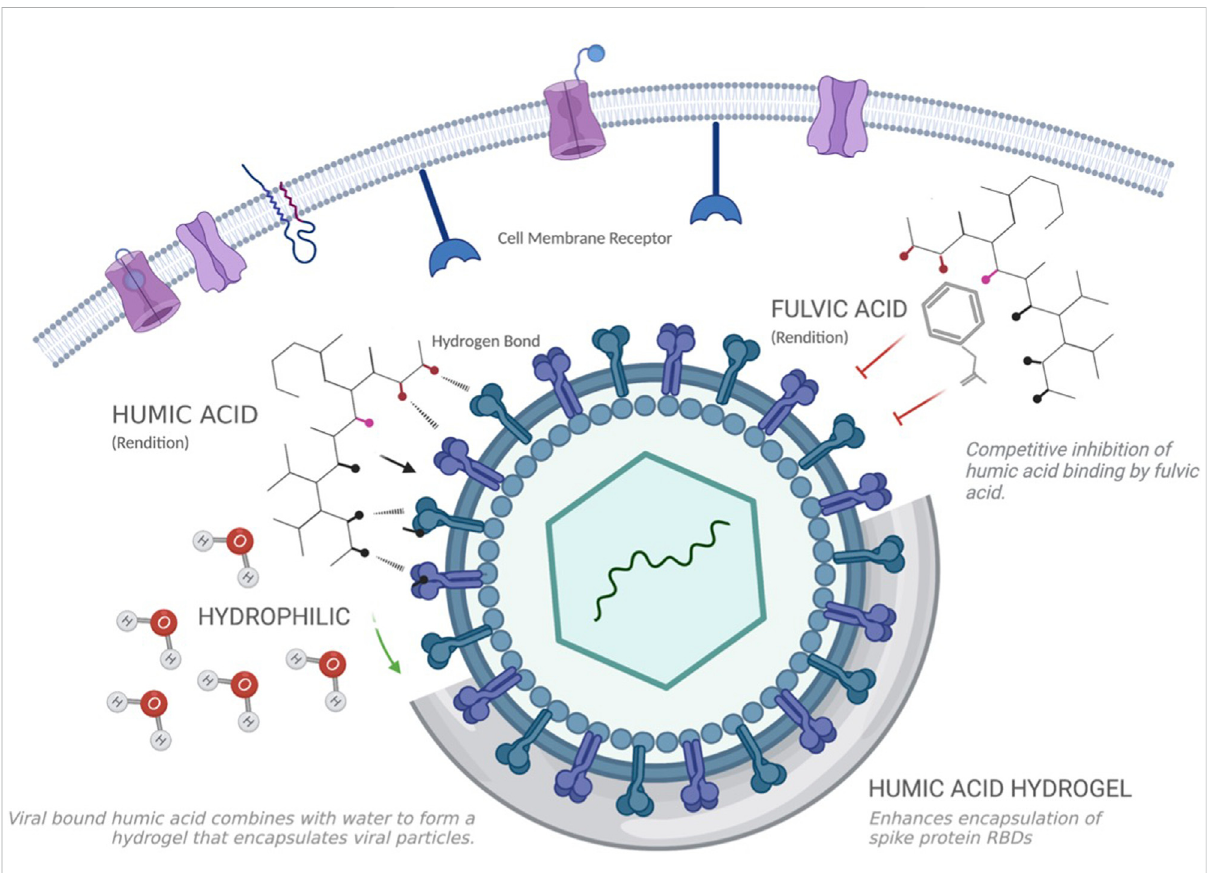
FIGURE 3 Humic acid binds to viral spike protein receptor binding domains (RBD) and inhibits viral fusion with target cell membrane receptors. The hydrophilic propertiesofthehumicacidmoleculeattractwatertoformahydrogelwhichencapsulatesspikeproteinRBDandsuspendsthevirallifecycle.Inthepresence of fulvic acid, humic acid ’ s potential to bind spike protein RBDs is impaired, which is the molecule ’ s primary mechanism of action. Created with